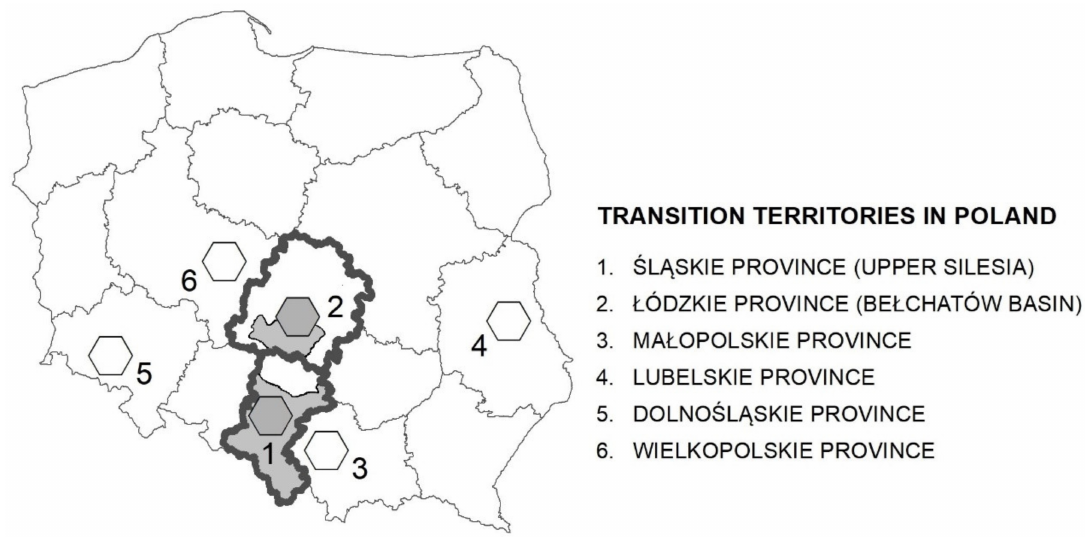
Figure 3. Map of Poland with transition territories indicated. Source: own study.